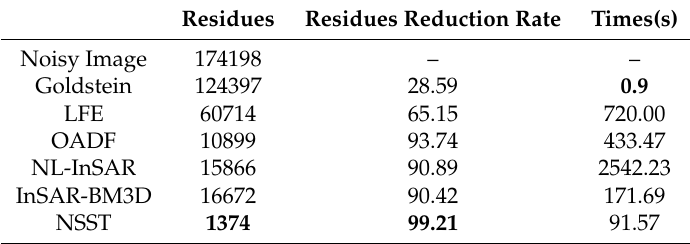
Table 7. Performance of various